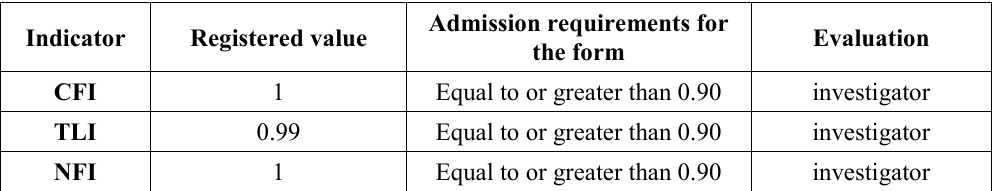
Table 9. Incremental and Comparative Indicators of the Study Model